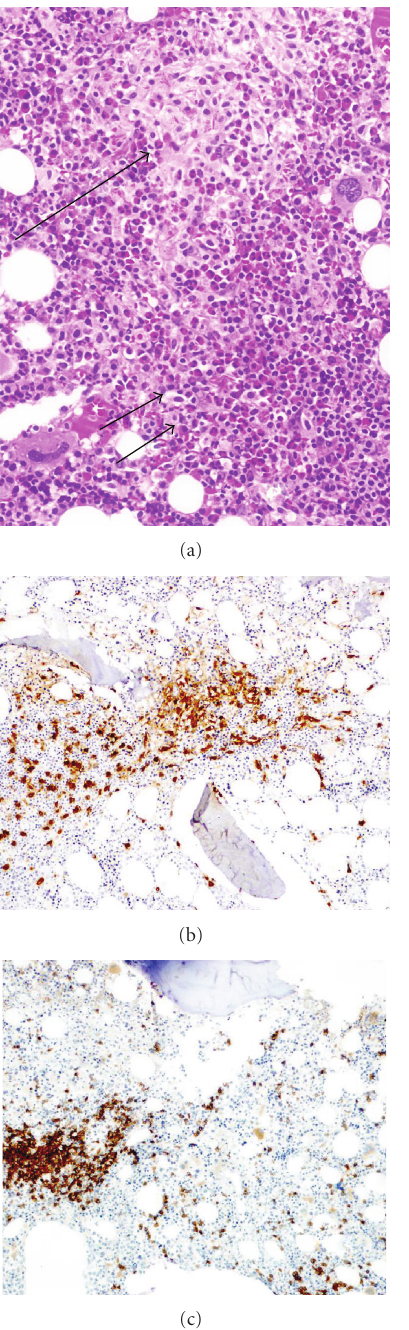
Figure 3: (a) Bone marrow biopsy with areas of infiltration by villous lymphocytes (2 arrows) and areas of infiltration by mast cells and fibrosis (arrow) (haematoxylin-eosin, original magnification × 200). (b) Areas of mast cell infiltration in the bone marrow (Mast cell stain × 150). (c) Villous lymphocytes in the bone marrow (CD20 stain ×